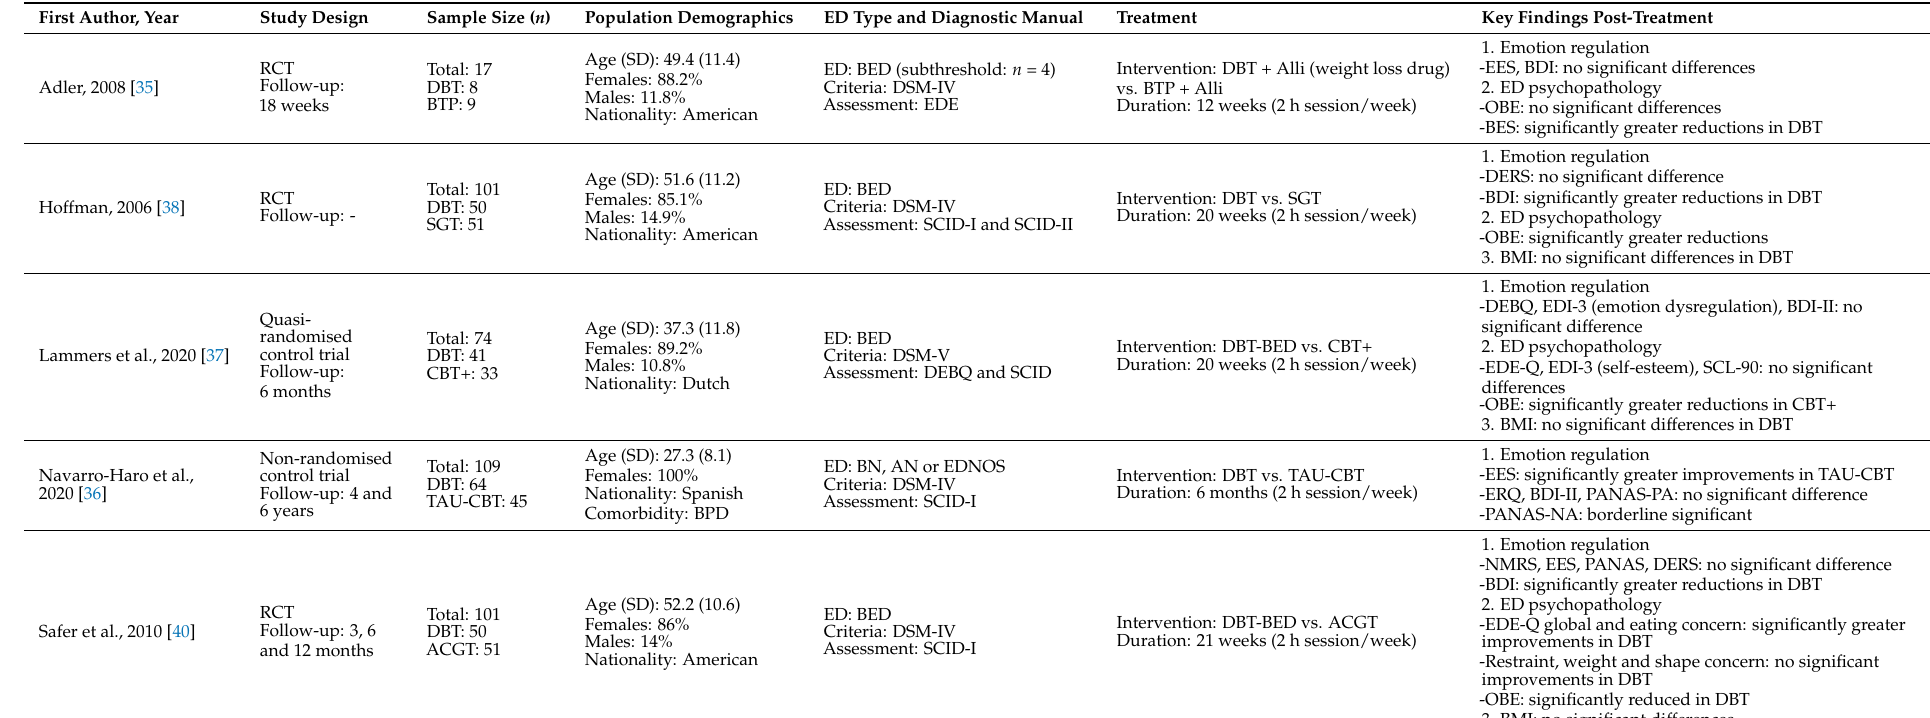
Table 2. Characteristics of the included studies (DBT vs. AT).